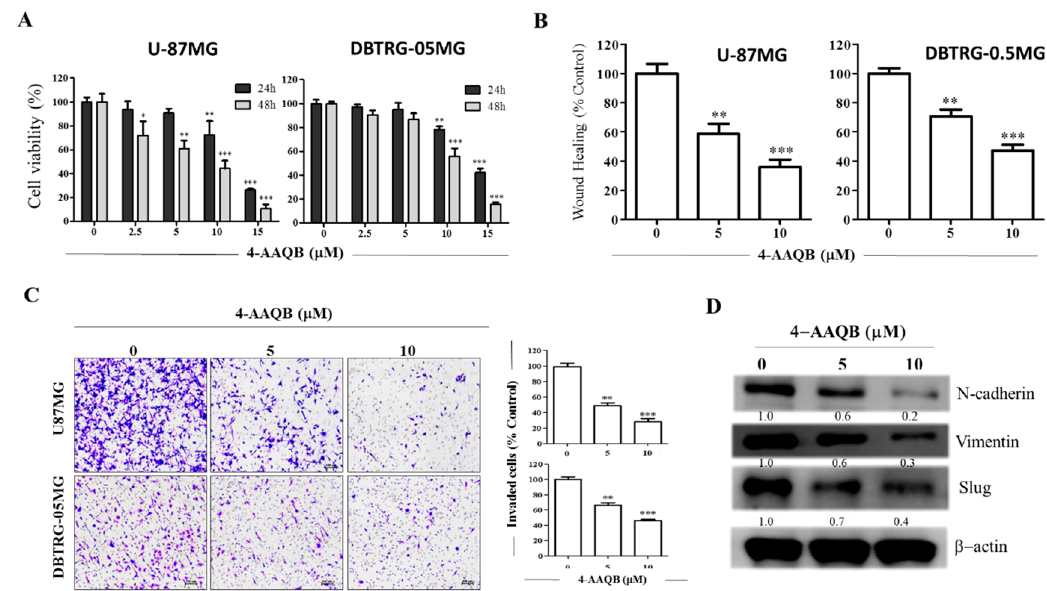
Figure 5. 4-AAQB significantly suppresses the viability and oncogenicity of GBM cells. ( A ) The dose- dependent cytotoxic effect of 4-AAQB on the cell viability of U-87MG and DBTRG-05MG. ( B ) Representative photo-images and graphical quantification showing the effect of 5 μ M and 10 μ M of 4-AAQB on the migration of U-87MG and DBTRG-05MG over 24 h duration. ( C ) 4-AAQB dose- dependently inhibit the number of invaded U-87MG and DBTRG-05MG cells. Scale bar: 50 μ m. ( D ) The inhibitory effect of 5 M and 10 M 4-AAQB on the expression levels of β -catenin, vimentin, and slug proteins in DBTRG-05MG cells as shown by Western blot assay. β -actin served as loading control. * p < 0.05, ** p < 0.01, *** p < 0.001; All data is representative of experiments performed 4 times in triplicates.